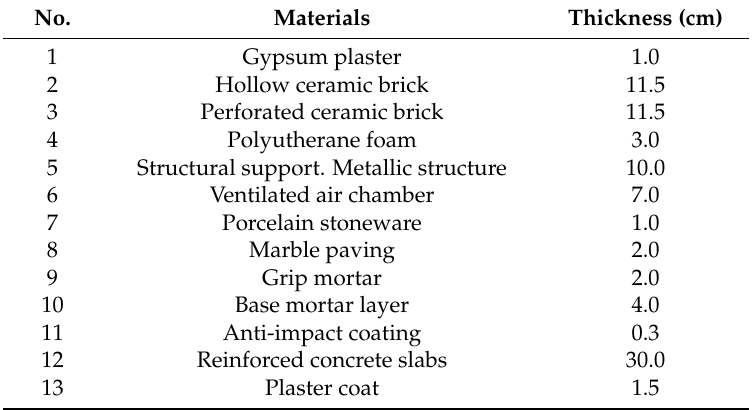
Table 4. The description of the building materials that make up the enclosure and the floor